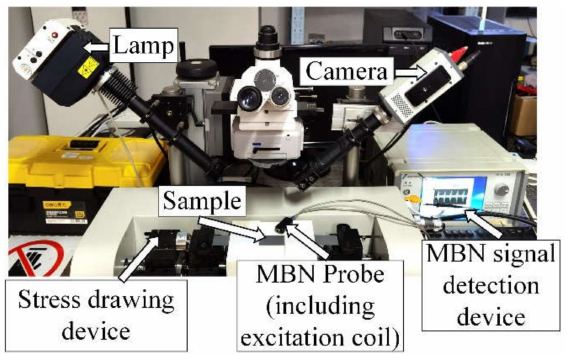
Figure 3. Experimental set-up for DW and MBN